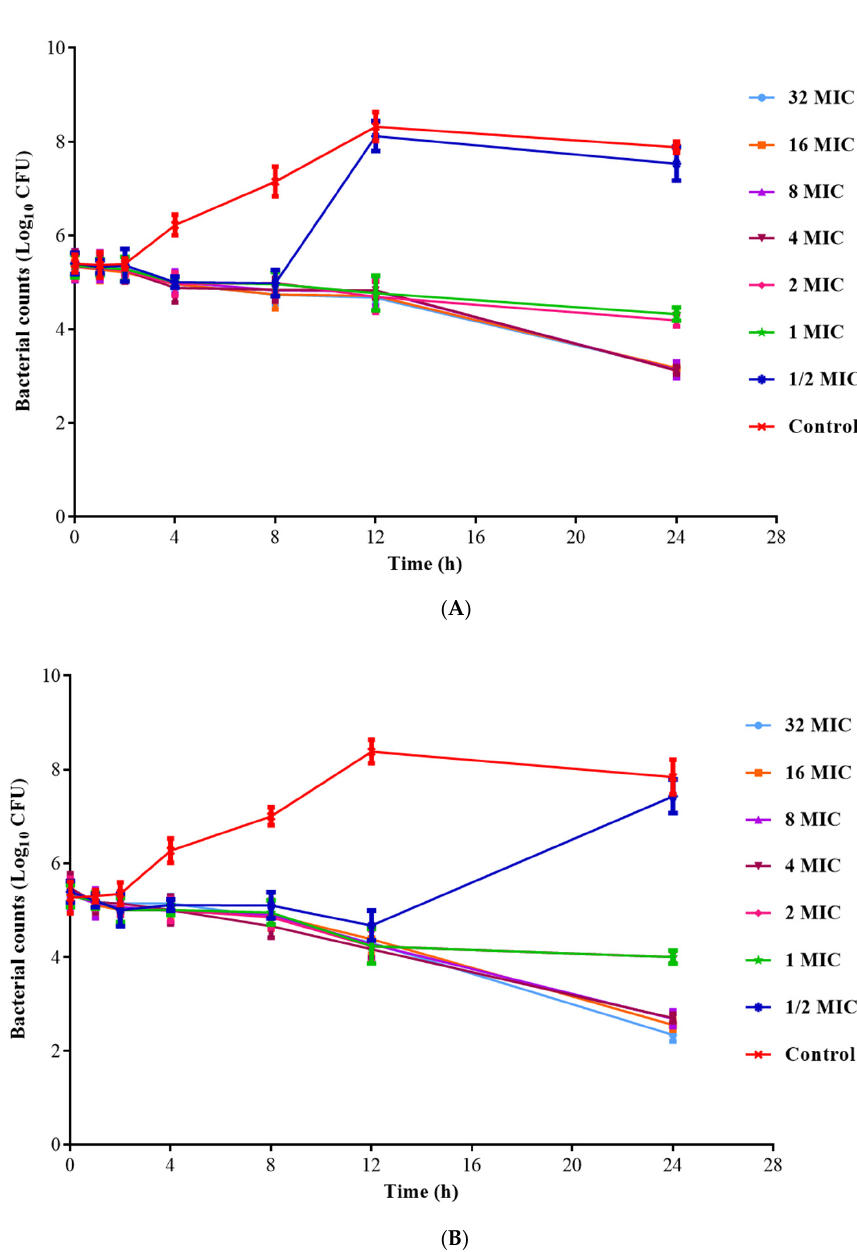
Figure 3. The time killing curves of ADP ( A ) and ADP/SMZ compound ( B ) against G. parasuis H78 in broth.